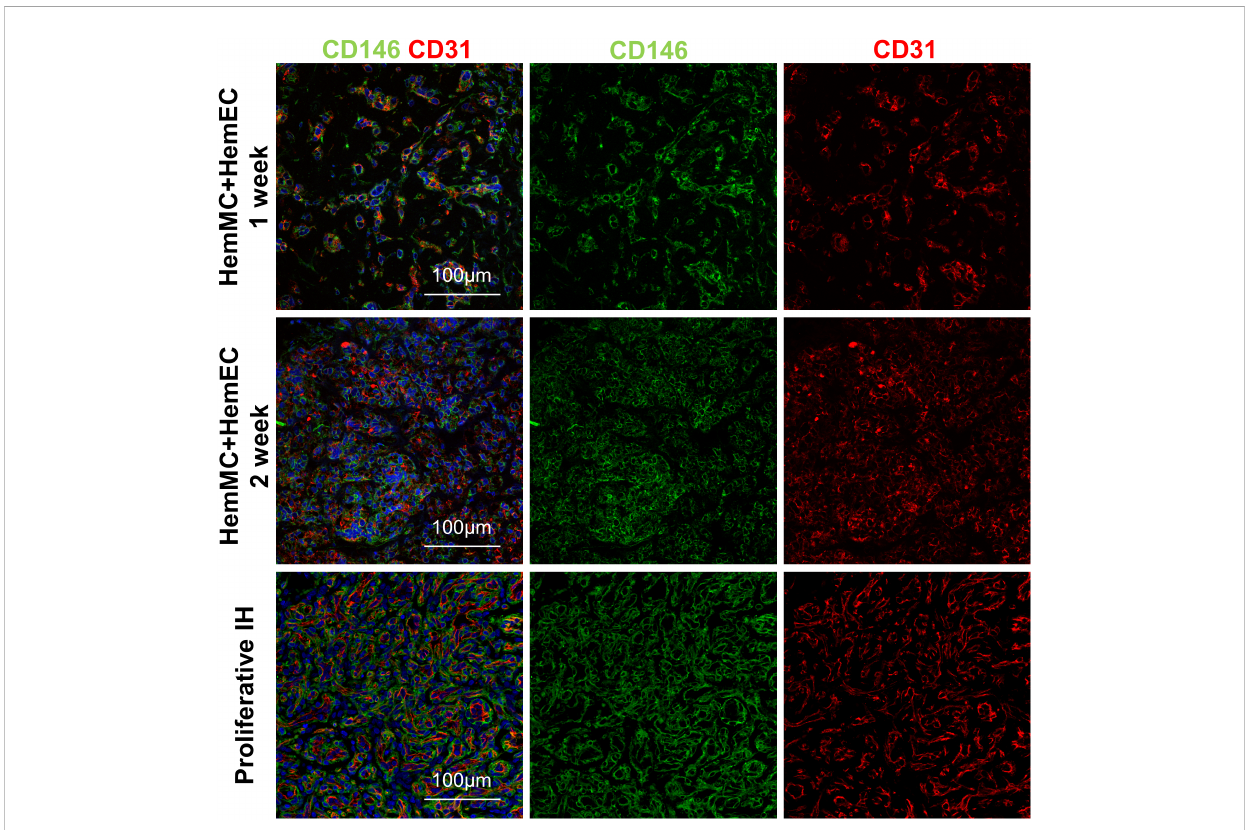
FIGURE 2 HemMCs and HemECs survive and proliferate in a xenograft model. A mixture of HemECs and HemMCs in Matrigel was injected into nude mice. Explants were harvested at 1 and 2 weeks and then subjected to immunostaining of CD146 and CD31. Scale bars=50 m m. All nuclei were counterstained DAPI (blue). HemMCs, infantile hemangioma mural cells; HemECs, infantile hemangioma endothelial